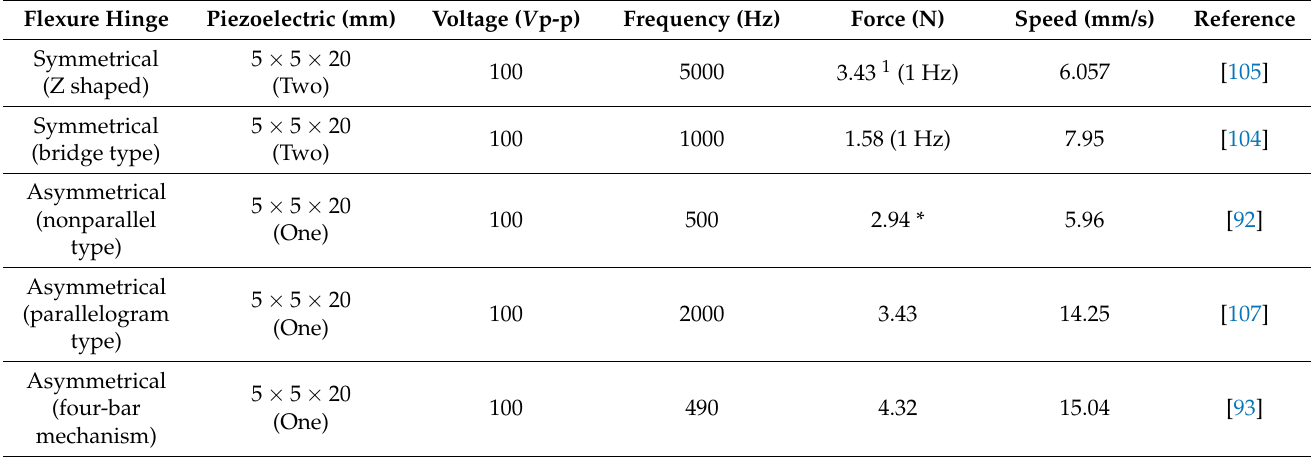
Table 4. Performance of a typical piezoelectric-based actuator.